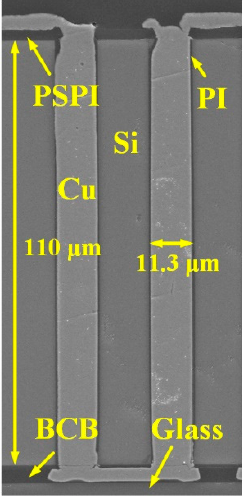
Figure 11. SEM image of fabricated TSVs with double-side RDLs.